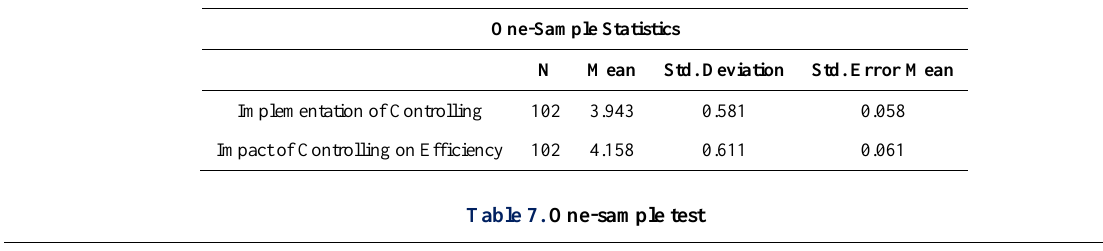
Table 6. One-sample statistics